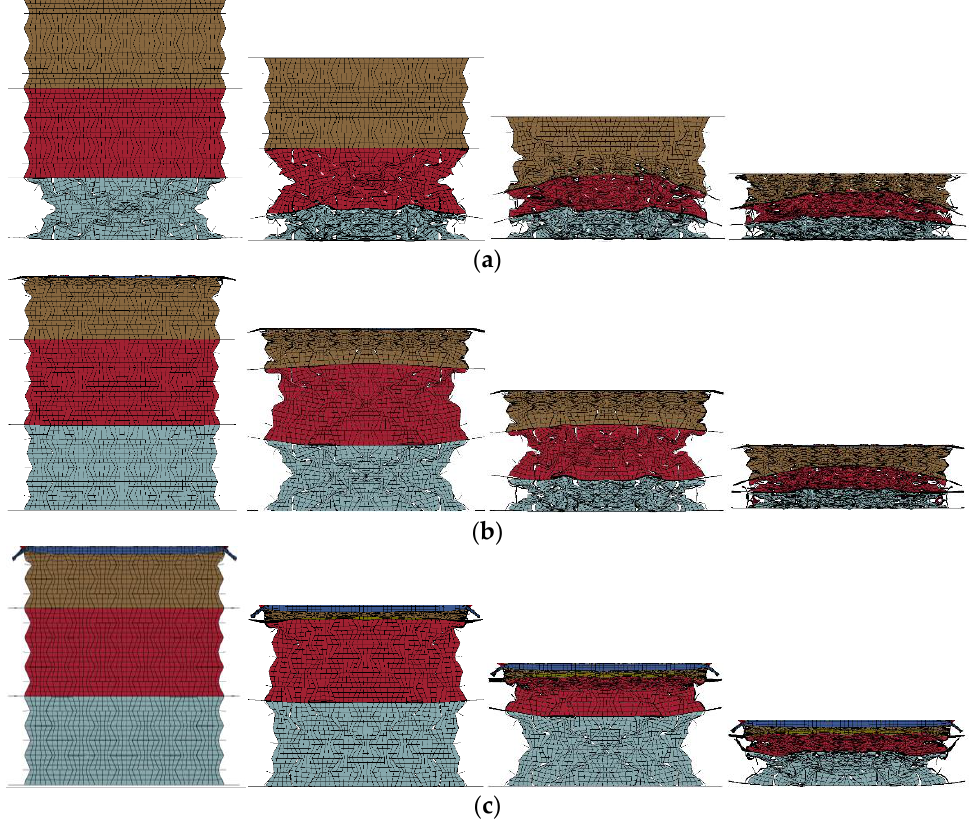
Figure 24. The response modes of the composite ( t = 0.4:0.4:0.4 and ρ = 848:575:408): ( a ) quasi-static mode (1 m/s); ( b ) transitional mode (10 m/s); ( c ) progressive collapse mode (100 m/s).